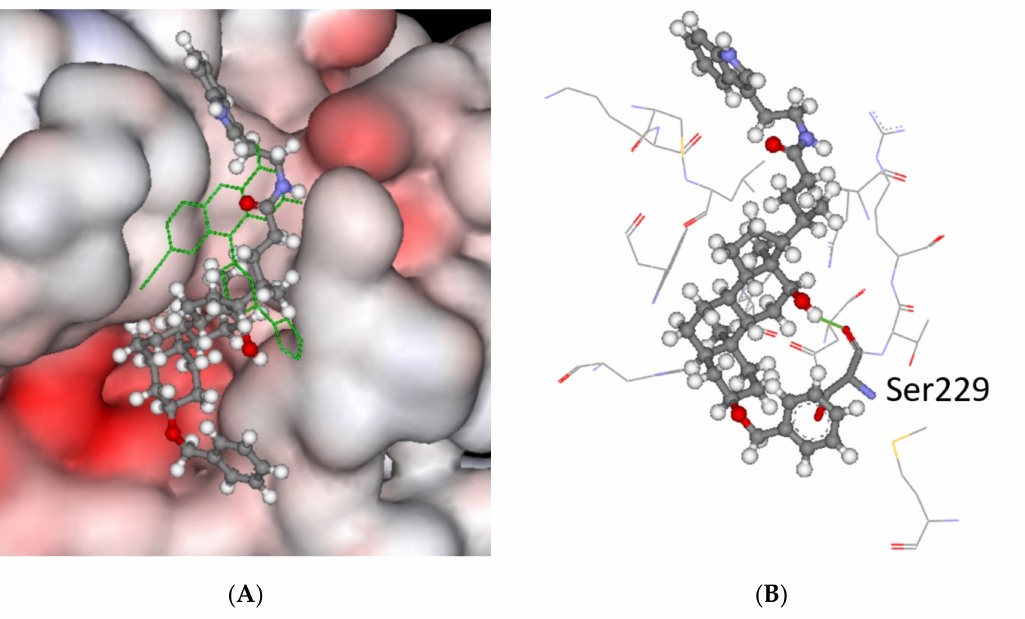
Figure 5. The docked pose of 5 in the catalytic site of TDP2 as predicted by the ChemPLP scoring function. ( A ) The ligand is shown in the ball-and-stick format. The co-crystallized ligand is shown (green lines). The protein surface is rendered; blue depicts regions with a partial positive charge on the surface; red depicts regions with a partial negative charge and grey shows neutral areas. ( B ) The predicted configuration depicted as balls-and-sticks with hydrogen bonding to Ser229 (1.9 Å—green line) shown as sticks. The amino acids (<5 Å) making up the binding pocket are shown as lines. The hydrogens on the amino acids are not shown for